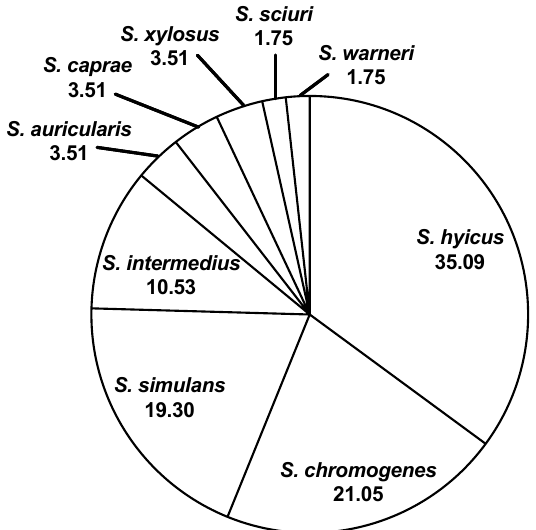
Figure 3. Identification (%) of non-aureus isolates (CNS and CPS). Given the concerns surrounding S. aureus and its impact on mammary health and milk production, we were also interested in determining whether a relationship existed between these nonhemolytic S. aureus isolates and afflicted quarters of the dairy animal. Previous research found a relationship between S. aureus infection and the quarter affected, where front teats were more likely to be infected with S. aureus compared to rear teats [11]. Therefore, we investigated this potential dynamic in the current study. In quarters infected with nonhemolytic S. aureus , 32.39% of the isolates were collected from the right front (RF) quarters, 23.24% from the left front (LF) quarters, 17.61% from the left rear (LR) quarters, and 26.76% from the right rear (RR) quarters (Figure 4). The left quarters displayed fewer nonhemolytic infections numerically; however, only the LR statistically differed from the RF and RR, with fewer identified S. aureus infections ( p < 0.05). In quarters infected with CNS, 26.23% of the isolates were collected from the RF quarters, 22.95% from the LF quarters, 31.15% from the LR quarters, and 19.67% from the RR quarters. In contrast to the S. aureus infections, the LR CNS cases were significantly greater than the RR ones ( p < 0.05), but not different from the RF or LF ones. Lastly, in quarters infected with CPS, 36.84% of the isolates were collected from the RF quarters, 31.58% from the LF quarters, 21.05% from the LR quarters, and 10.53% from the RR quarters. The RF CPS cases were significantly greater than the RR